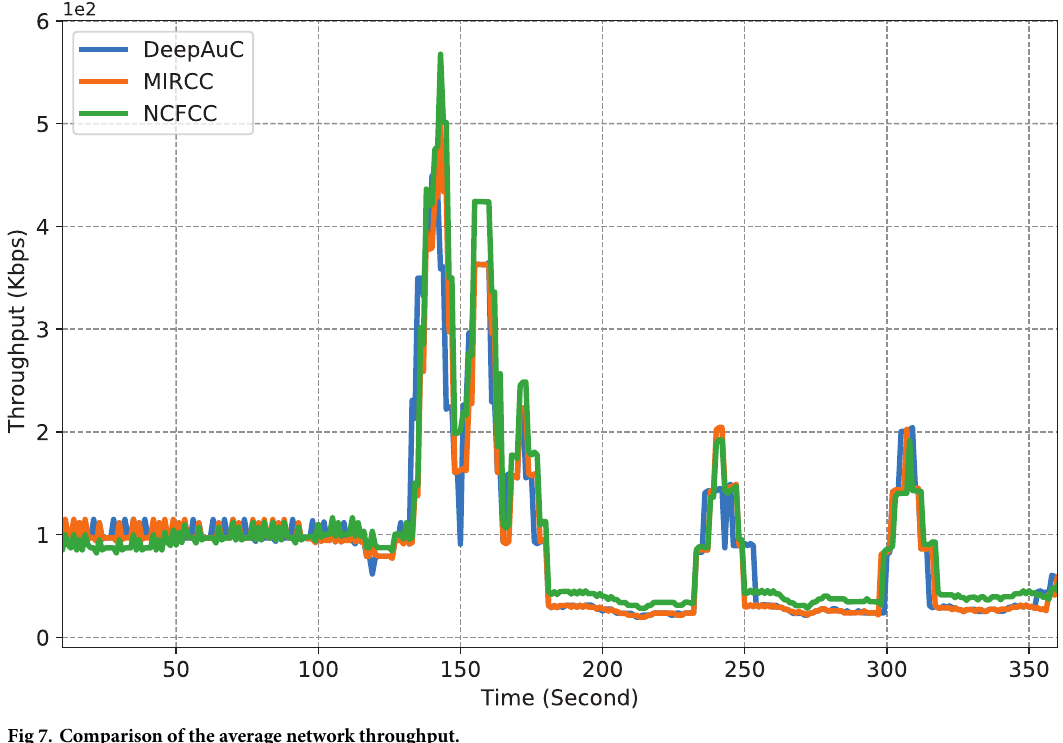
Fig 7. Comparison of the average network